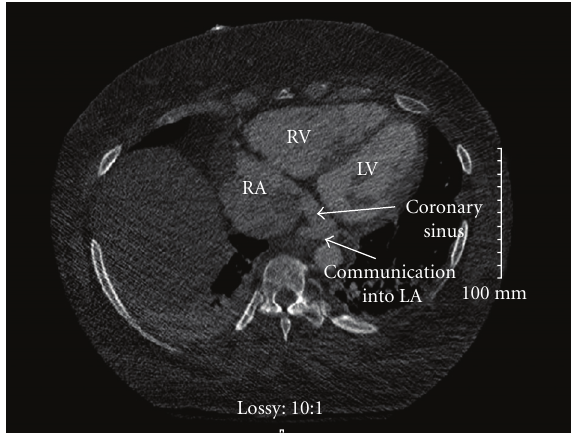
Figure 4: Cardiac CTA. The arrows indicate the coronary sinus with a communicating vessel to the